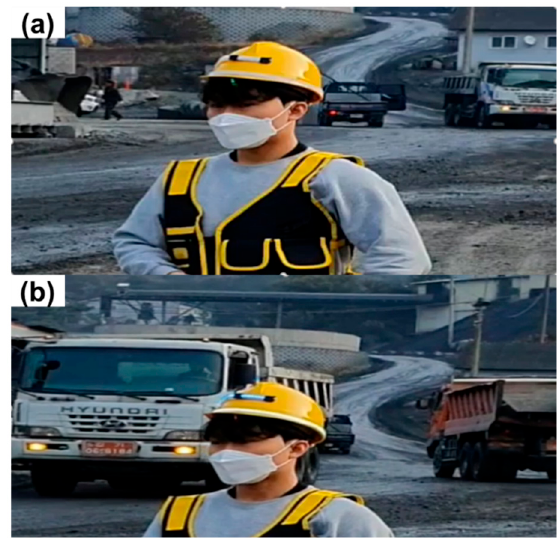
Figure 13. Visual warning provided by the AI smart helmet. ( a ) Before the mining equipment reaches the hazardous area; ( b ) When the mining equipment reaches the hazardous area. Table 3. Results of the accuracy evaluation of the hazard warning of the AI smart helmet according to the face angle between the camera module and the mining equipment.